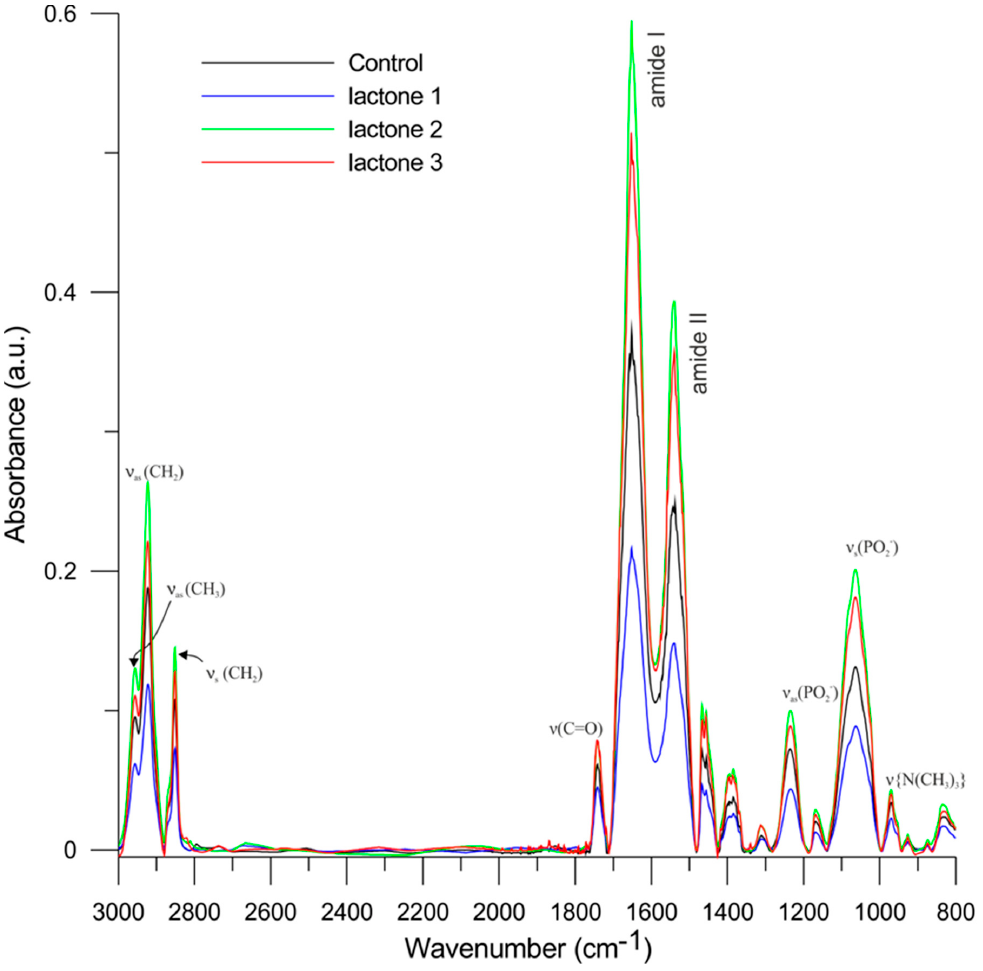
Figure 5. Fourier Transform Infrared (FTIR) spectra of red blood cells membranes (RBCMs, black lines) and of RBCMs modified with lactone 1 —blue lines, lactone 2 —green lines, and lactone 3 —red lines at 37 °C. Table 5. Maxima of the main of FTIR spectrum bands for control (RBCMs) and tested samples (RBCMs + lactones).